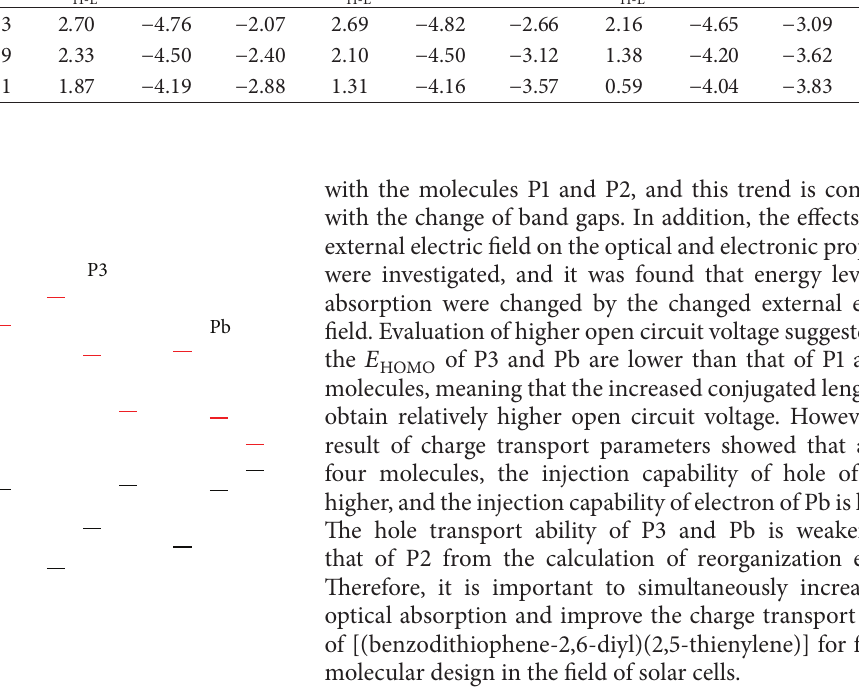
Table 7: HOMO and LUMO energy levels and band gaps of the dipolymers under external electric field (eV). Field ( × 10 −3 a.u.)